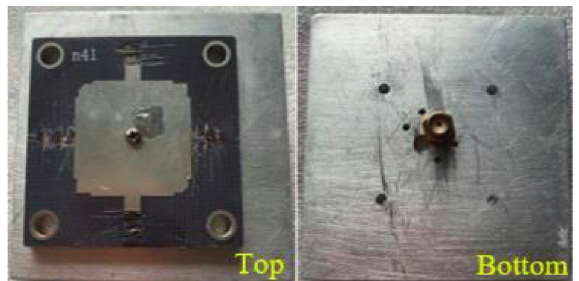
Figure 4: Fabrication of microstrip CP patch antenna